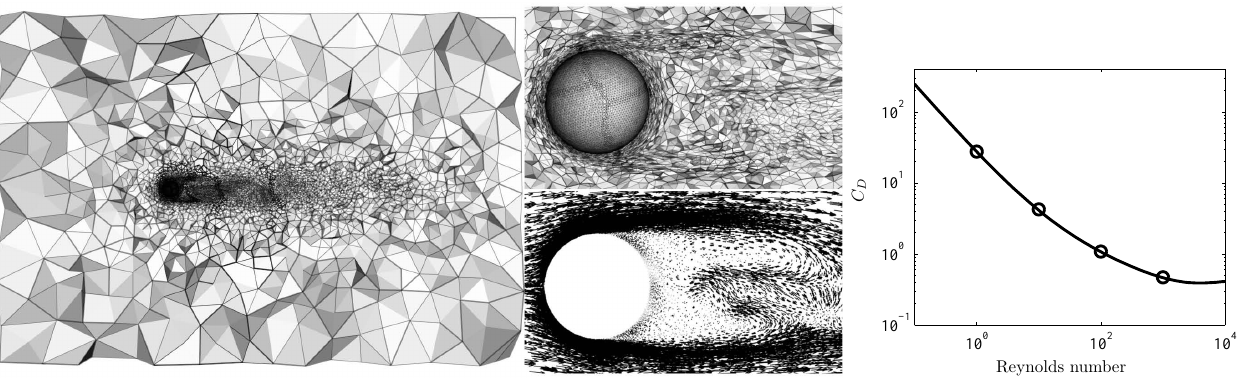
Fig. 5. Left: unstructured adapted mesh from flow past a sphere simulation at Re = 103, with half the domain cut away to display refinement close to the sphere and in its wake. Centre: a blow up of the mesh and velocity vectors on a plane through the centre of the domain. Right: comparisons between the computed drag coefficient (circles) and the correlation (solid line) given by expression (18) in the range Re ∈[ 1 , 1000 ] .